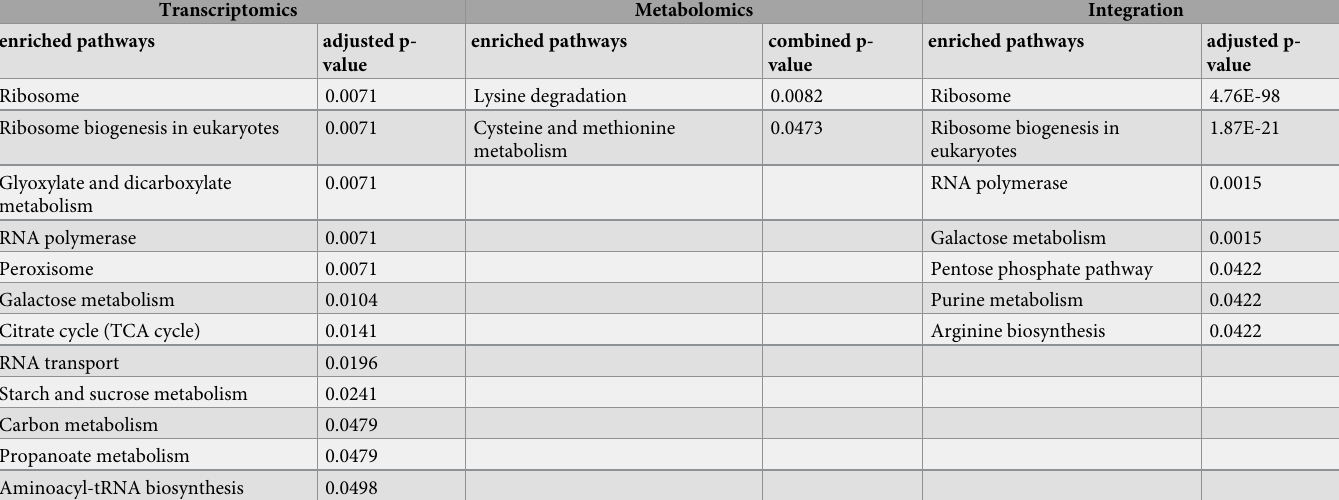
Table 5. Single- and Multi-omics integration results for asc1 by sensitivity analysis. First block shows GSEA for transcriptomics with adjusted p-value < 0.05, arranged in ascending order; second block shows MetaboAnalystR pathway enrichment analysis for metabolomics with combined p-value < 0.05, arranged in ascending order; third block shows MetaboAnalystR joint pathway analysis with adjusted p-value < 0.05, arranged in ascending order, as detailed in